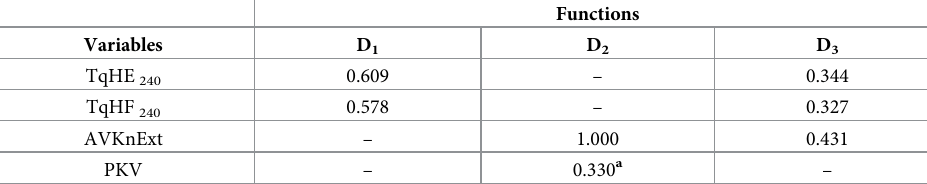
Table 4. Structure matrix: Pooled between-group correlations between discriminant variables and standardized canonical discriminant functions.